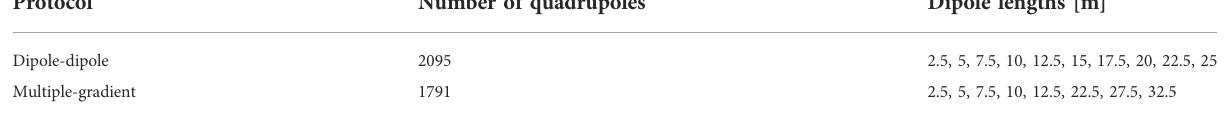
TABLE 1 Characteristics of the used electrode con fi gurations, namely, dipole-dipole combining different dipole lengths and multiple-gradient. For the latter, the dipole lengths refer to the size of potential dipoles nested inside the current dipole.